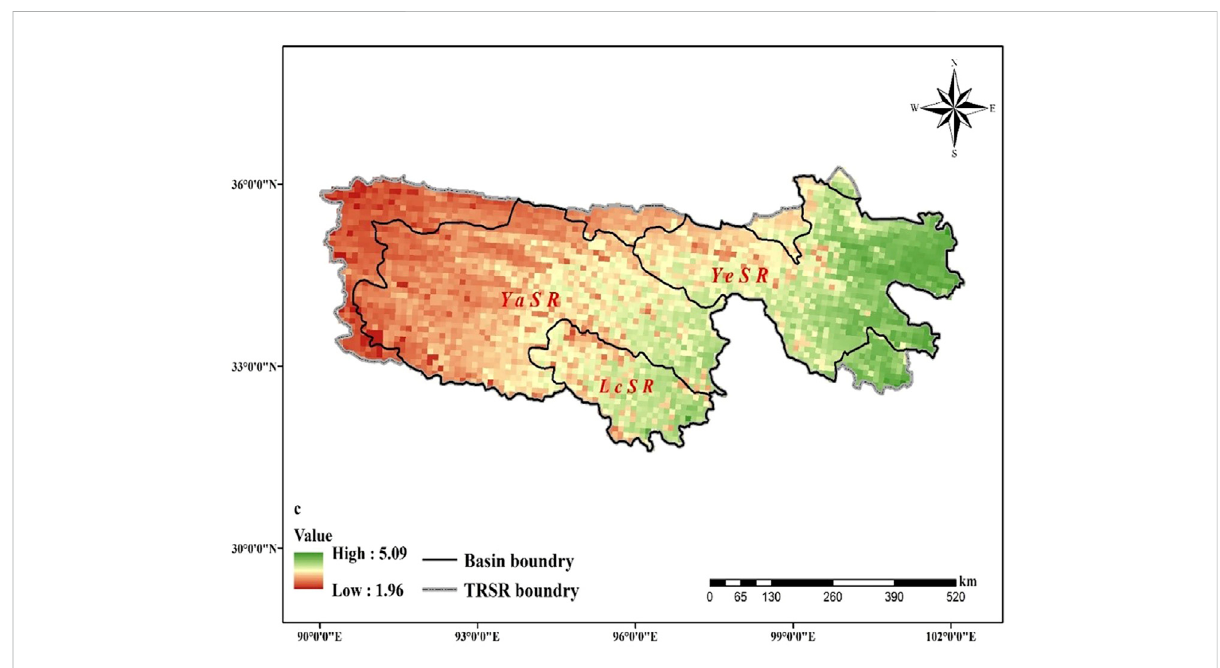
FIGURE 8 Spatial distribution of model parameter c in the TRSR of Tibetan Plateau,